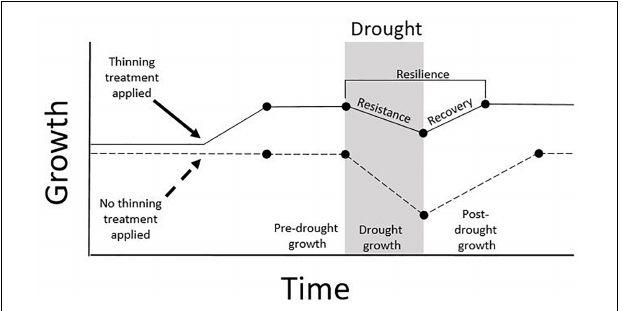
FIGURE 1 | Hypothetical growth responses of individual trees to drought (shaded area) following thinning treatment. The solid line depicts a tree that responds to treatment with higher growth, relatively little loss in growth during drought (high resistance), and a relatively rapid return to pre-drought growth rate (high resilience). The dashed line depicts a tree in an untreated stand that subsequently experiences greater loss of growth during drought (low resistance) and requires longer to recover the pre-drought growth rate (low